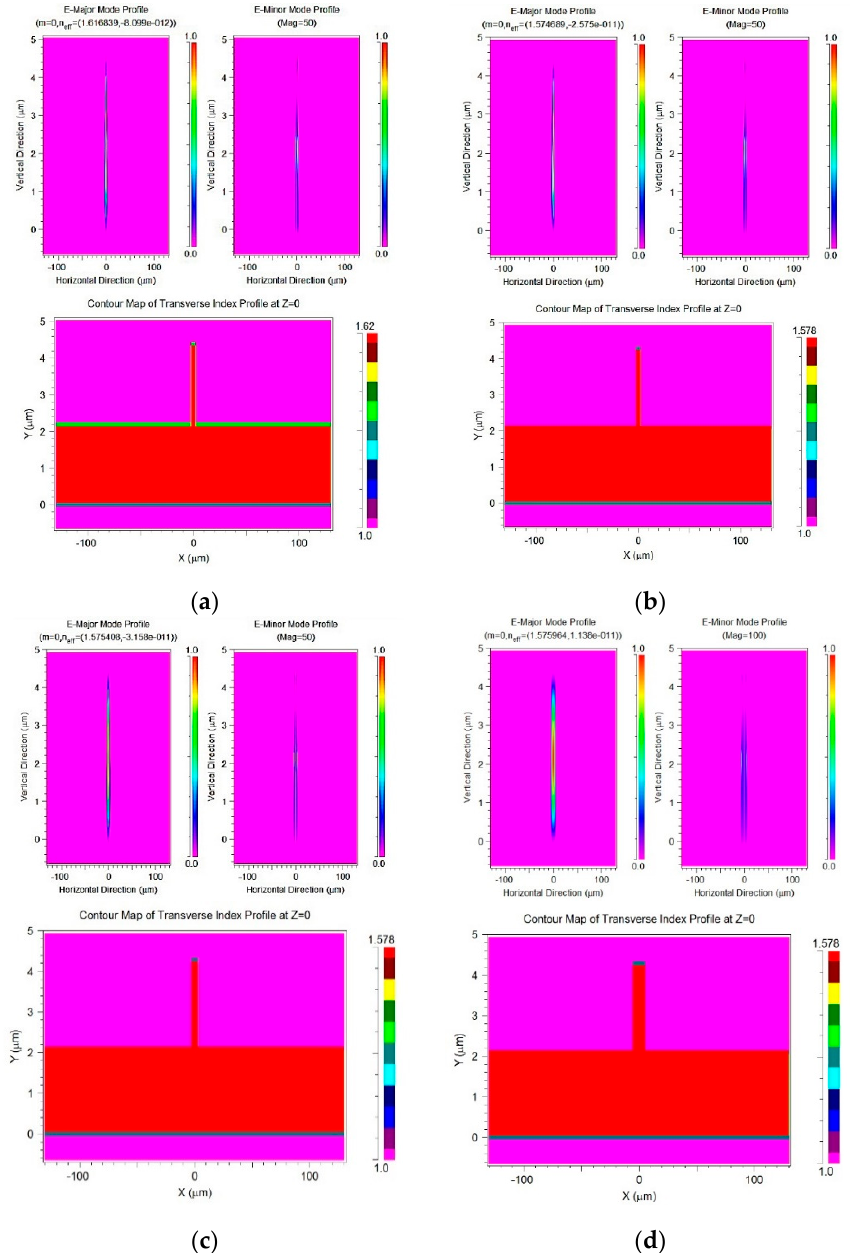
Figure 11. Index and modal profile of the proposed rib waveguide at λ = ( a ) 400 and ( b ) 650 nm with r = 0.5 and at 650 nm with ( c ) r = 0.7 ( d ) and r = 0.9 respectively.